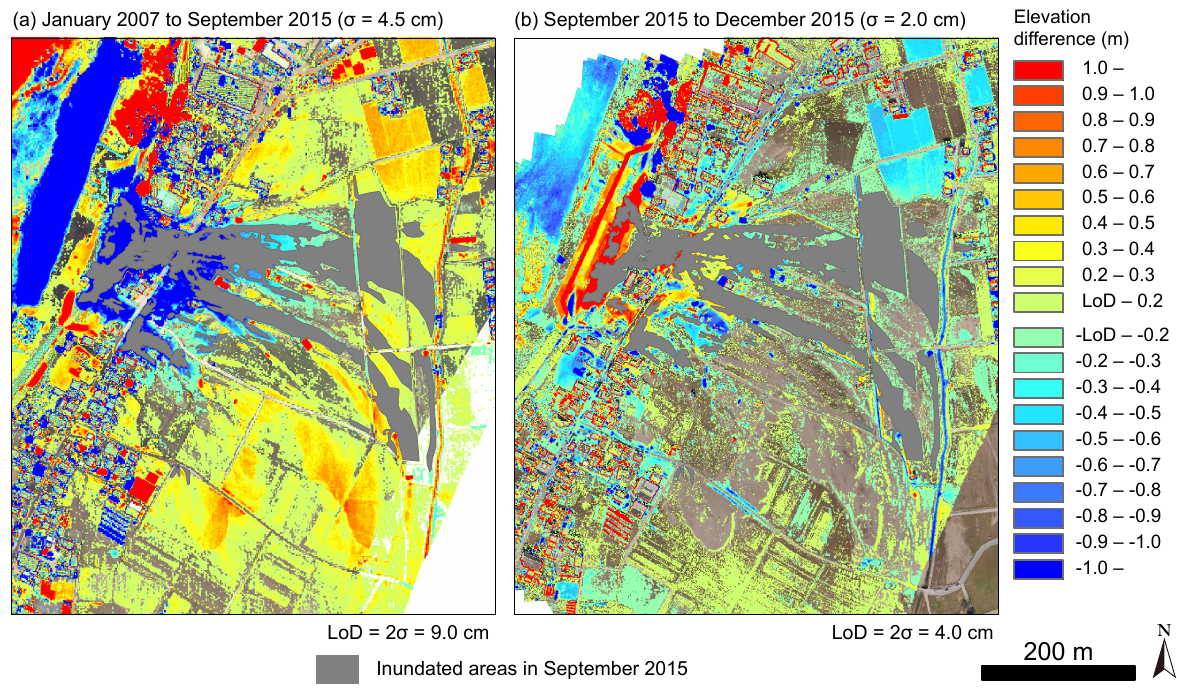
Figure 6. Differential rasters indicating the elevation differences between two successive snapshots after the removal of the systematic error and the adjustment of resolution. (a) The January 2007 DSM subtracted from the September 2015 DSM. Note that erosion near the breached levee was more than 1m. (b) The September 2015 DSM subtracted from the December 2015 DSM. Note that in DSM areas inundated in September 2015 are masked (see Fig. 8 for the elevation changes in these